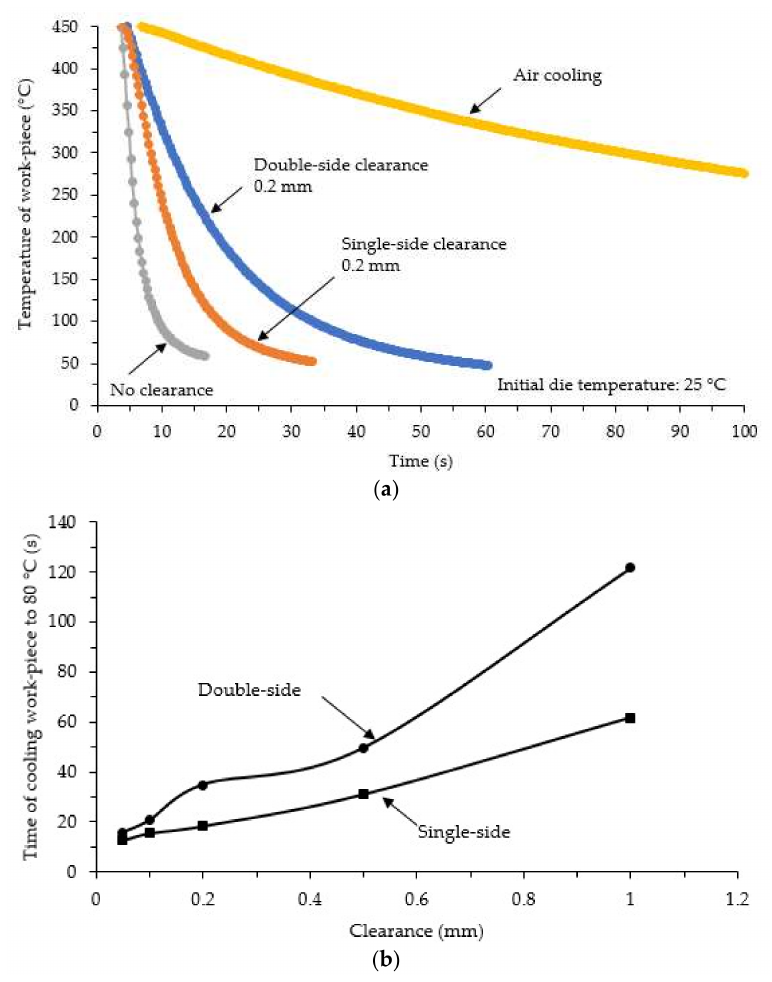
Figure 11. Effects of die clearance on ( a ) cooling of work-piece and ( b ) in-die quenching